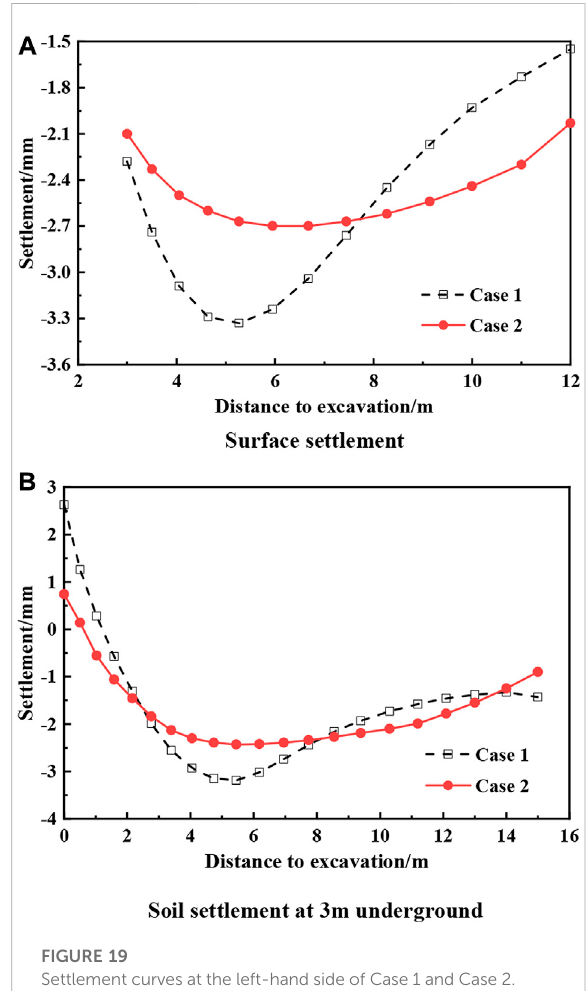
FIGURE 19 Settlement curves at the left-hand side of Case 1 and Case